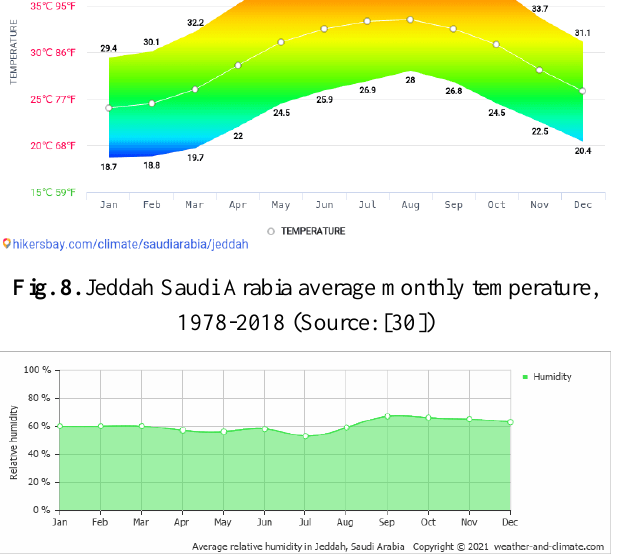
Fig. 9. Jeddah Saudi Arabia Average monthly relative humidity in one year (Source: